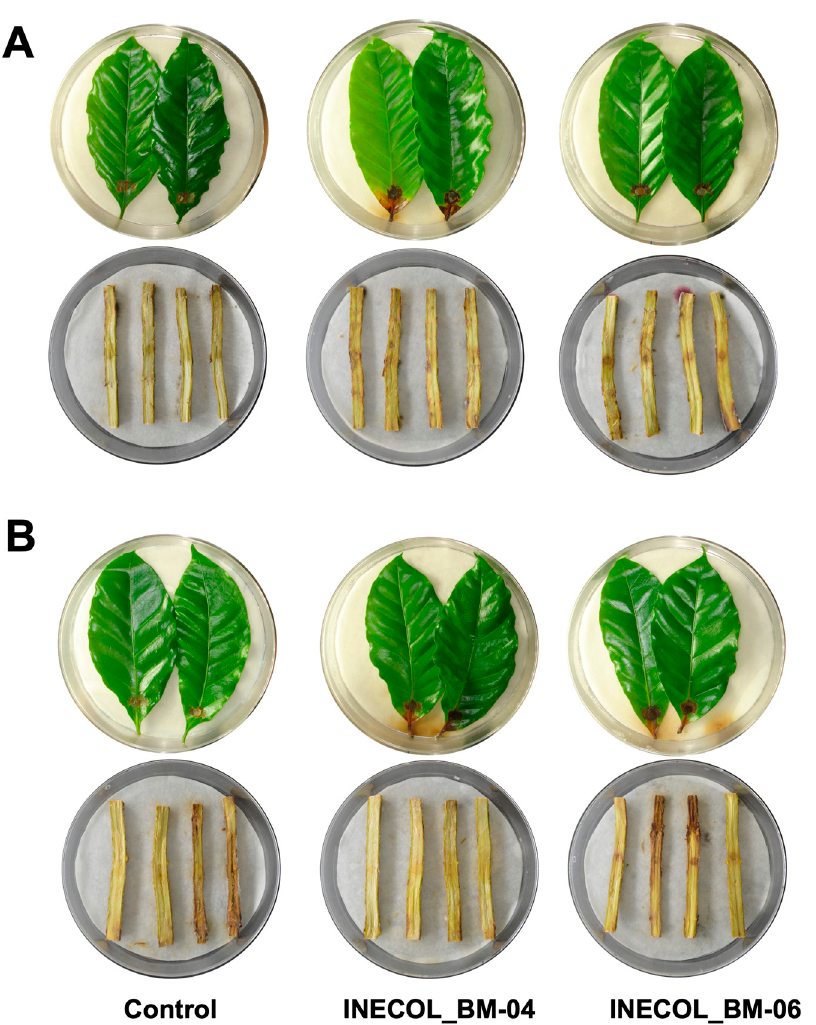
Figure 4. Pathogenicity screening of Fusarium sp. INECOL_BM-04 and Fusarium sp. INECOL_BM-06 isolates in leaves and vascular tissue of Coffea arabica . ( A ) C. arabica cv. Marsellesa ( B ) C. arabica cv. Oro azteca. Photographs were taken at 21 dpi.